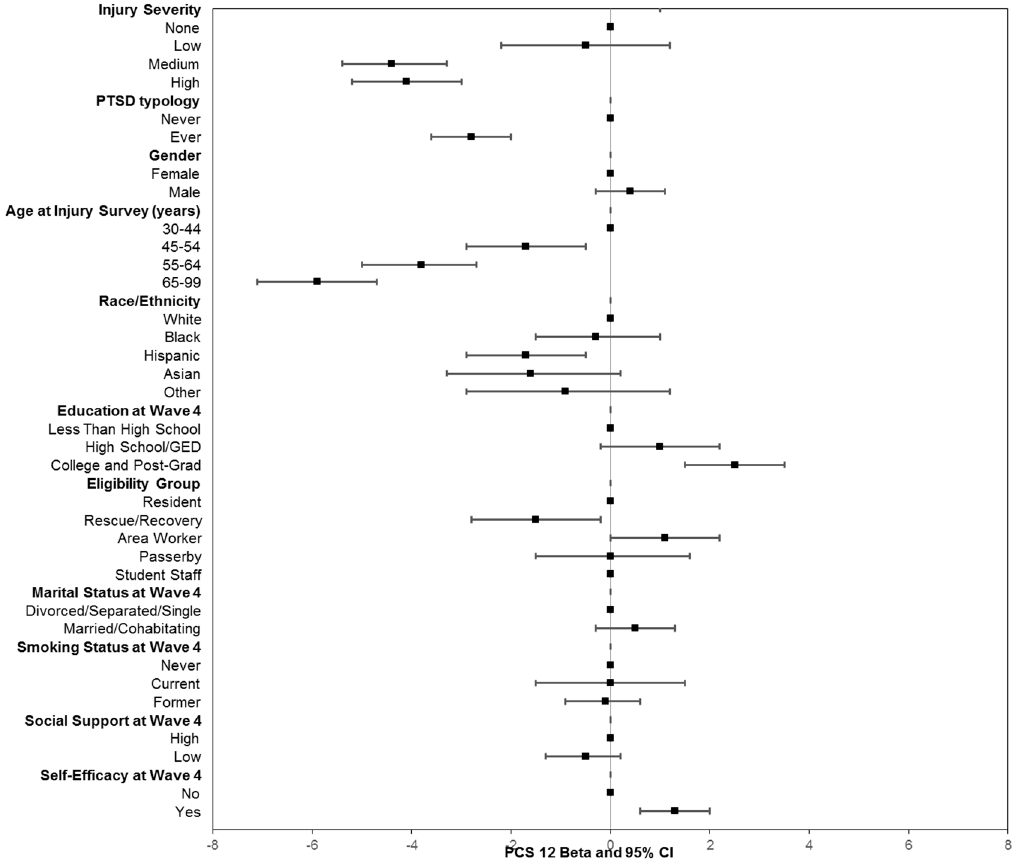
Figure 1. Linear regression of PCS-12 (physical health functioning) as a function of injury severity, PTSD history, demographic, and other factors. The betas are the predicted changes in mean scores relative to the reference category. Controlled for all variables included in figure. PTSD check list score ≥ 44 on any prior WTCHR survey.